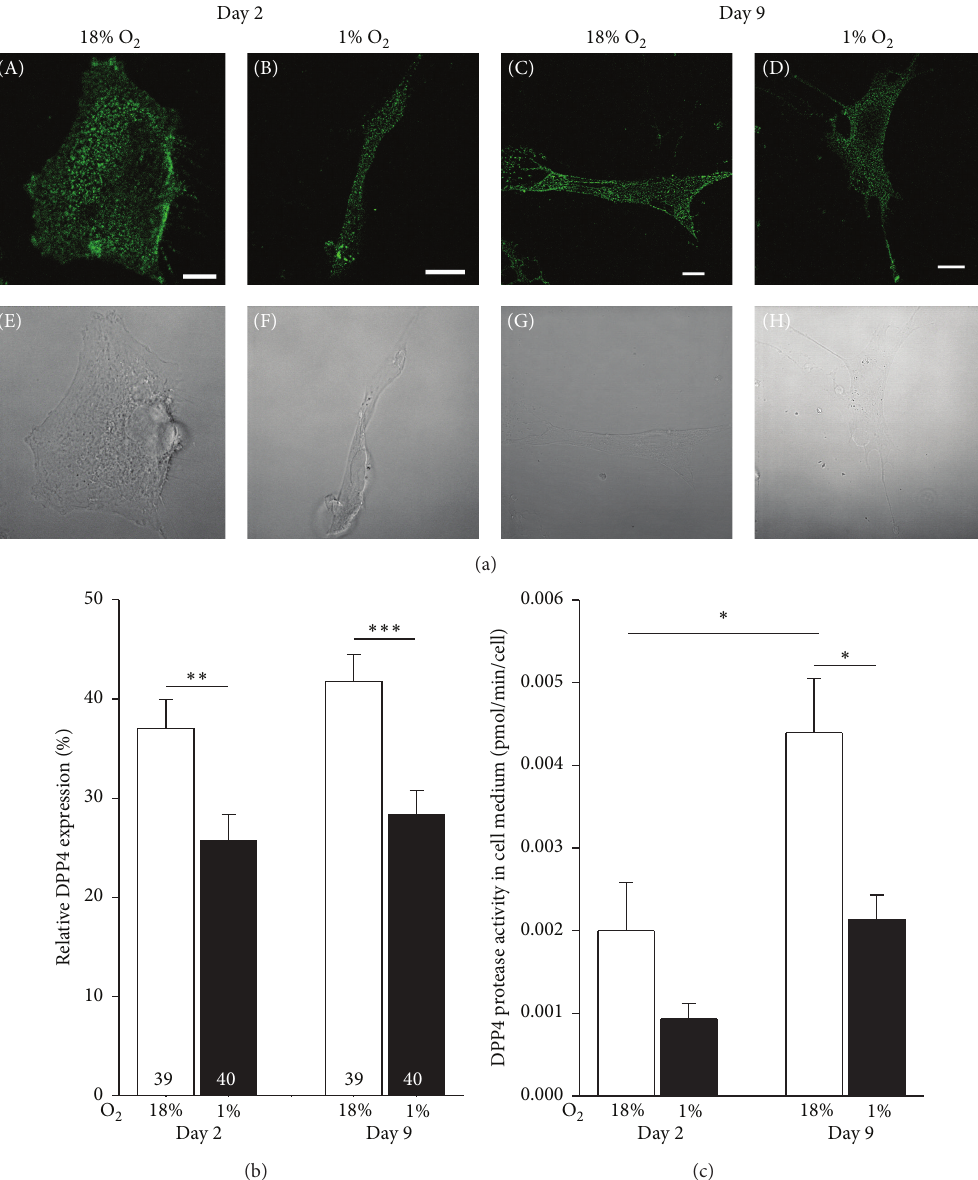
Figure 2: Oxygenation-dependent expression density and shedding of DPP4 in human preadipocytes cultured in vitro . (a) Confocal images (upper panels) and transmission light microscopy images (lower panels) of human preadipocytes (subconfluent cultures) immunolabeled with antibody against DPP4. Each panel shows representative confocal images of a cell incubated for 2 days (A, B, E, and F) and 9 days (C, D, G, and H) under normoxic (A, C, E, and G) and hypoxic (B, D, F, and H) environmental conditions. Scale bars indicate 10 𝜇 m. (b) Relative expression density of DPP4 in human preadipocytes cultured for 2 and 9 days in normoxic or hypoxic conditions. Numbers denote the number of cells imaged. (c) Normalized DPP4 protease activity in conditioned medium. Asterisks denote statistically significant difference ( ∗ 𝑃 < 0.05 ; ∗∗ 𝑃 < 0.01 ; ∗∗∗ 𝑃 < 0.001 , two-way